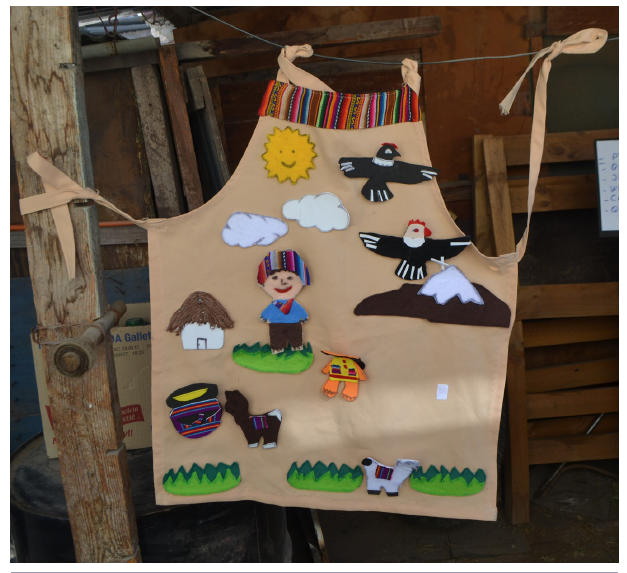
Fig. 3 . Apron with elements of the Andean landscape, including condors, used as a teaching aid by an intercultural teacher in Putre in the high Andes of northern Chile (Photo by Andrés